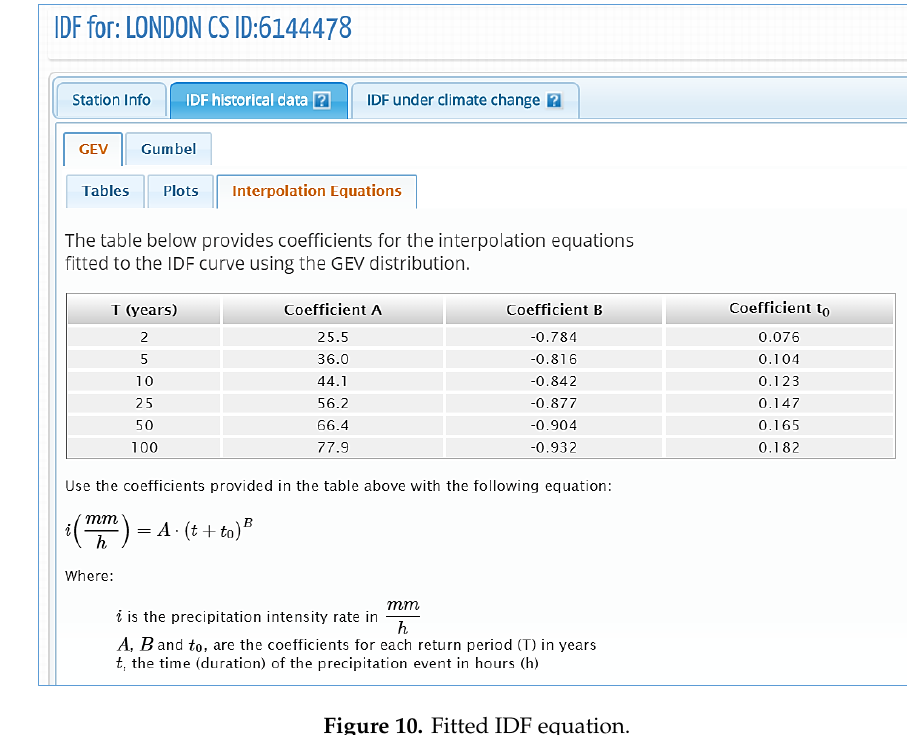
Figure 10. Fitted IDF equation.